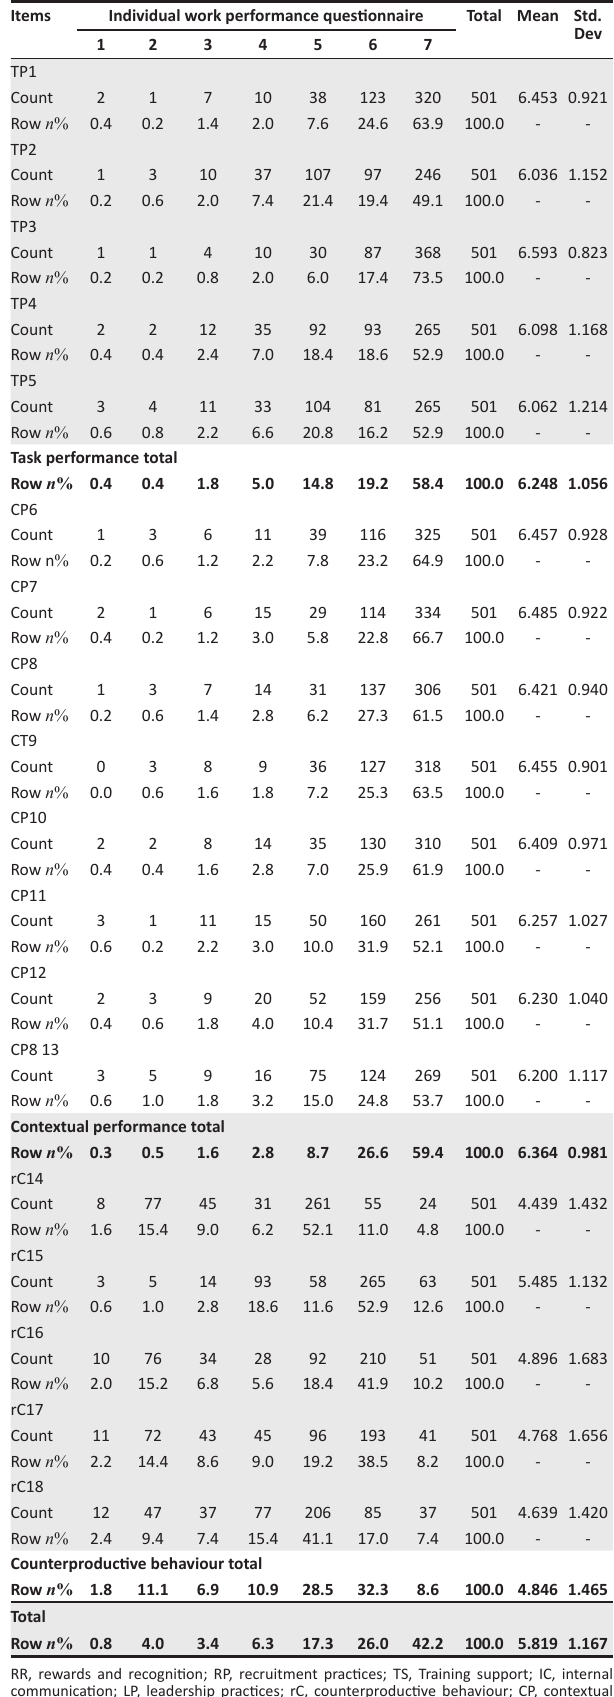
the study. Items Individual work performance